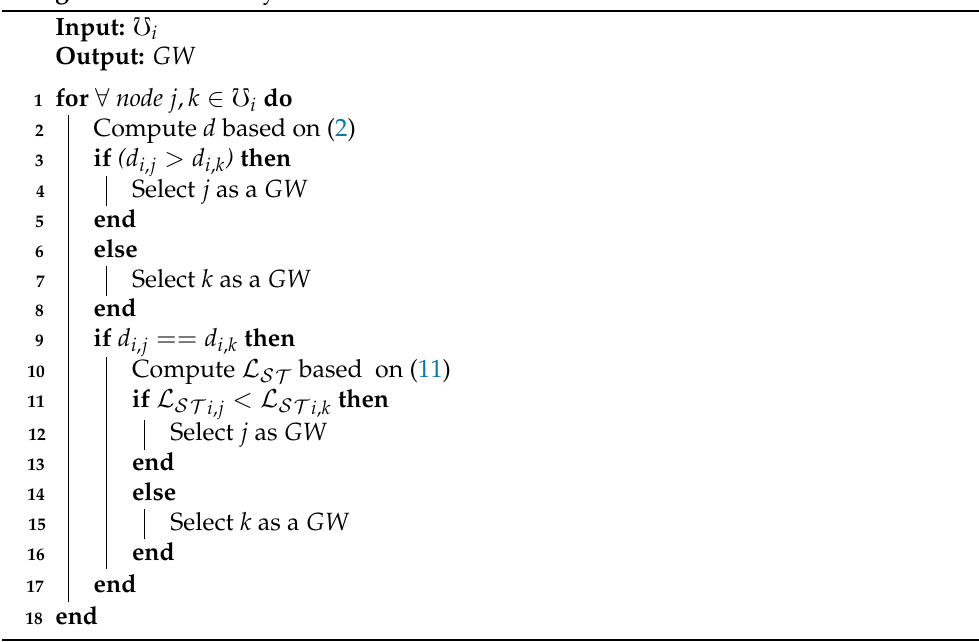
Algorithm 3: Gateway selection.